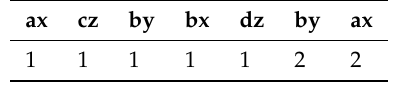
Table 5. MR-I results for existence constraints (activation).